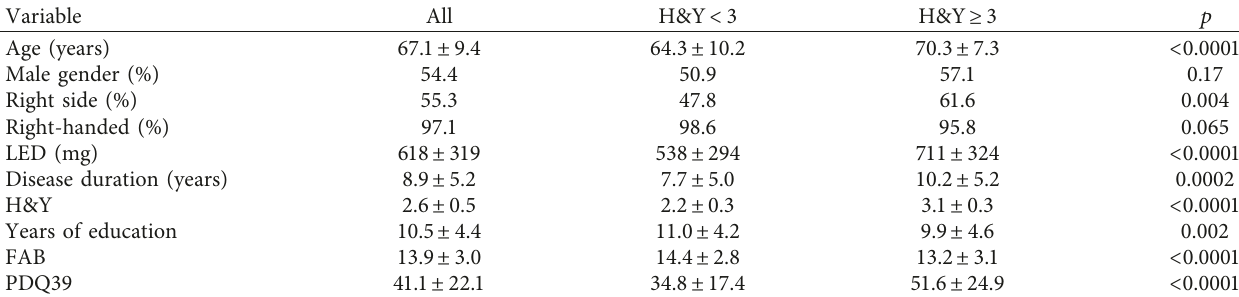
Table 1: Patients’ demographical, clinical, and neuropsychological